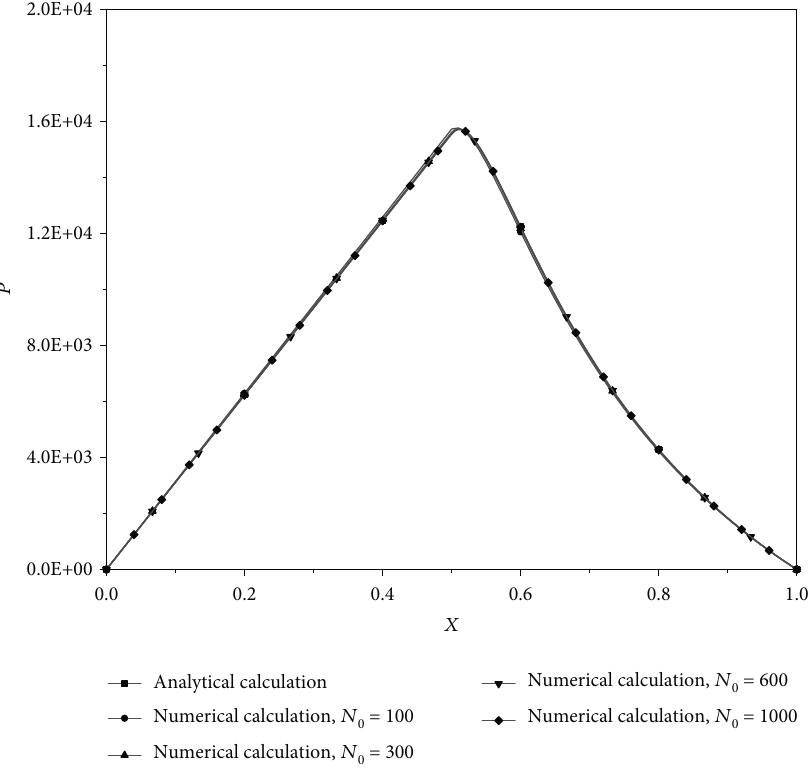
Figure 7: Comparison of the numerically solved pressures for di ff erent discretized points with the classical hydrodynamic theory calculation (i.e., analytical solution) [3] when the model of the bearing is assumed as classical, N